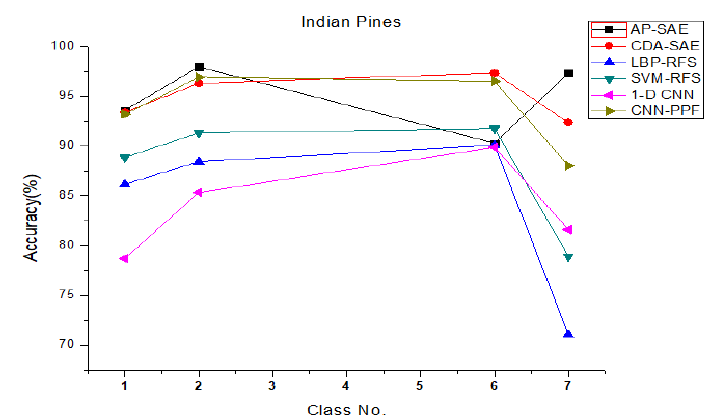
Figure 14. Different methods of various types of accuracy comparison results for the Indian Pines